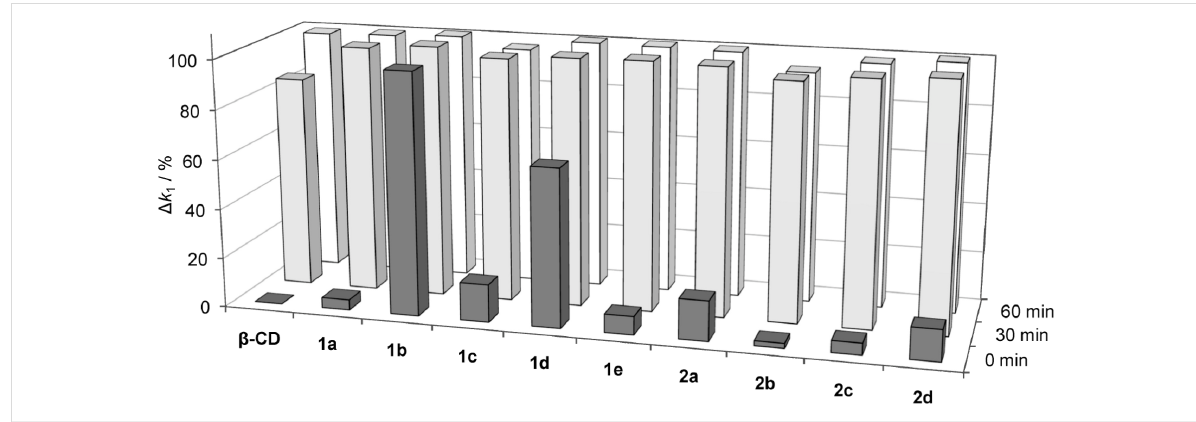
Figure 2: Diagram summarizing the observed Δ k 1 values for cyclodextrins 1a – e and 2a – d . For comparison, the results obtained for native β -cyclodextrin are also included in the diagram. Large bars indicate low enzyme inhibition and, consequently, high activity of the corresponding cyclodextrin. The results are averages over three independent